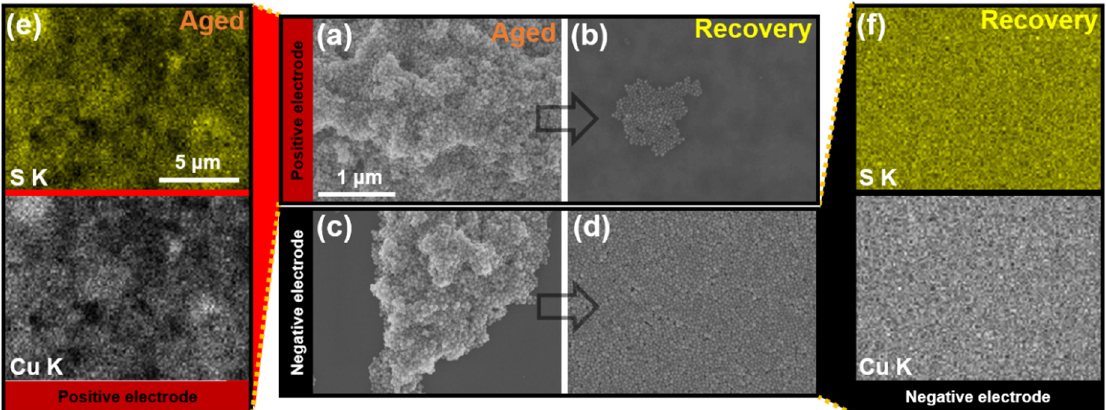
Figure 5. SEM images of the NP films fabricated on the positively charged substrate (top panel) and the negatively charged substrate (bottom panel) using the 720 h-aged NPs ( a , c ) and the recovered NPs ( b , d ). EDS mapping images of the aged sample on the positively charged substrate ( e ) and the recovered sample on the negatively charged substrate ( f ) are also